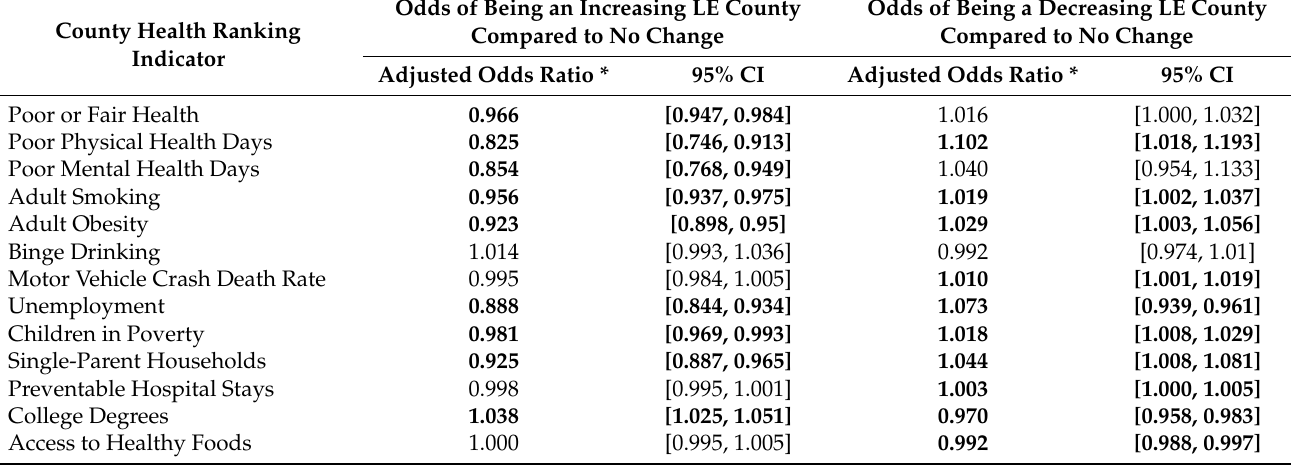
Table 3. Associations between modifiable determinants of health and increasing and decreasing life expectancy (LE)